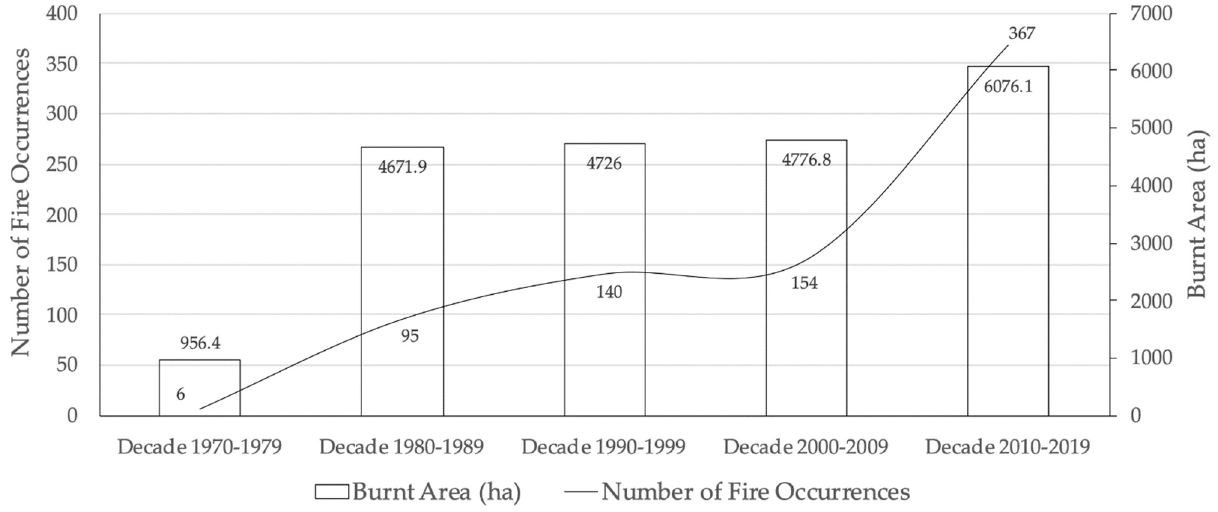
Figure 11. Evolution of the number of occurrences and area burnt during the past five decades in the municipality of Guimarães.